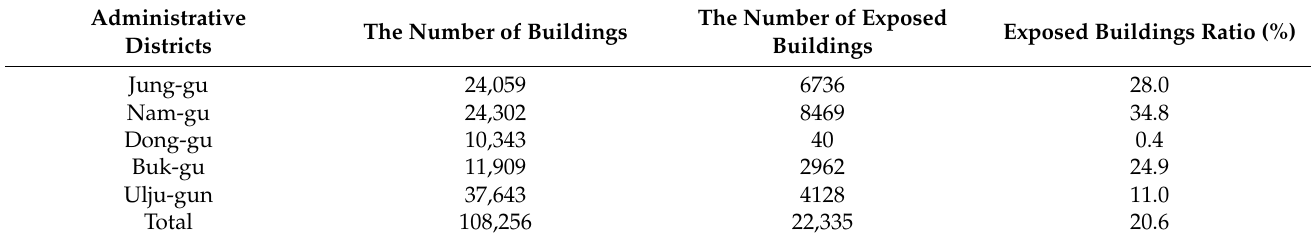
Table 8. Analysis results of exposure (exposed buildings to 100-year flood).